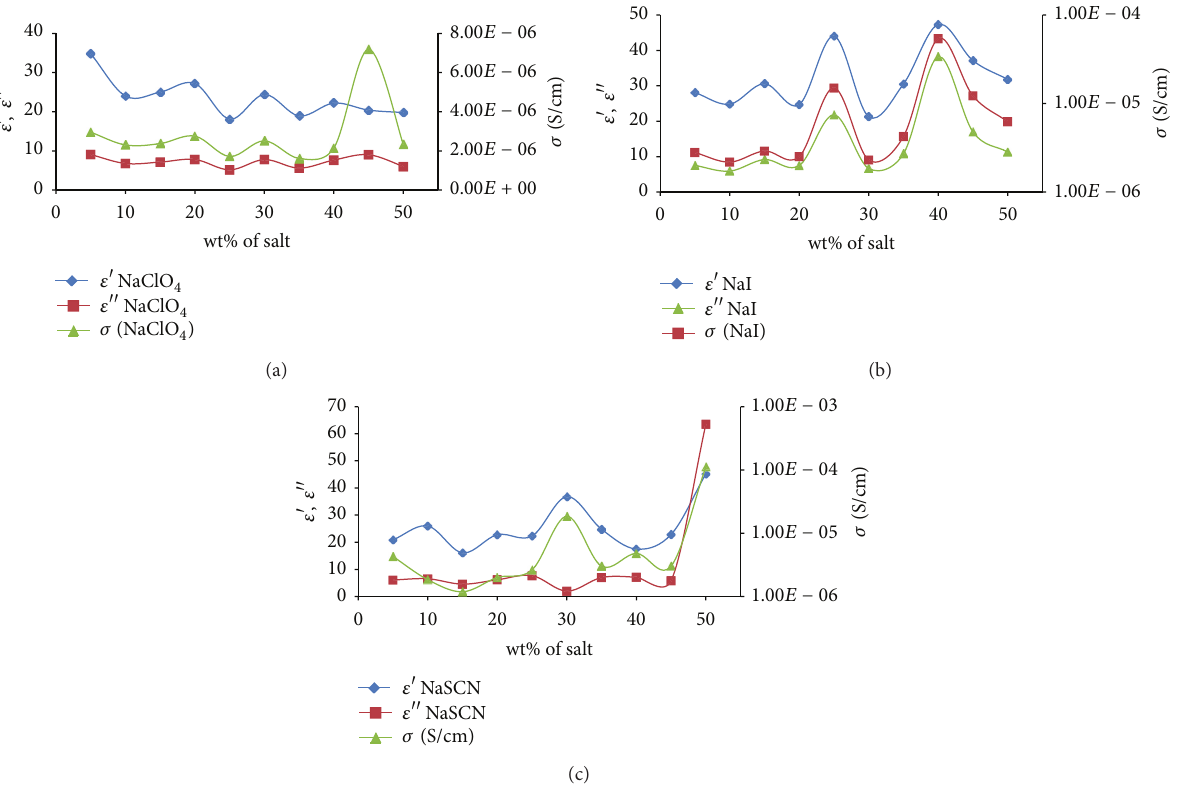
Figure 1: Variation of conductivity and dielectric parameter with wt% of added salt (a) NaClO 4 Salt, (b) NaI salt, and (c) NaSCN salt.